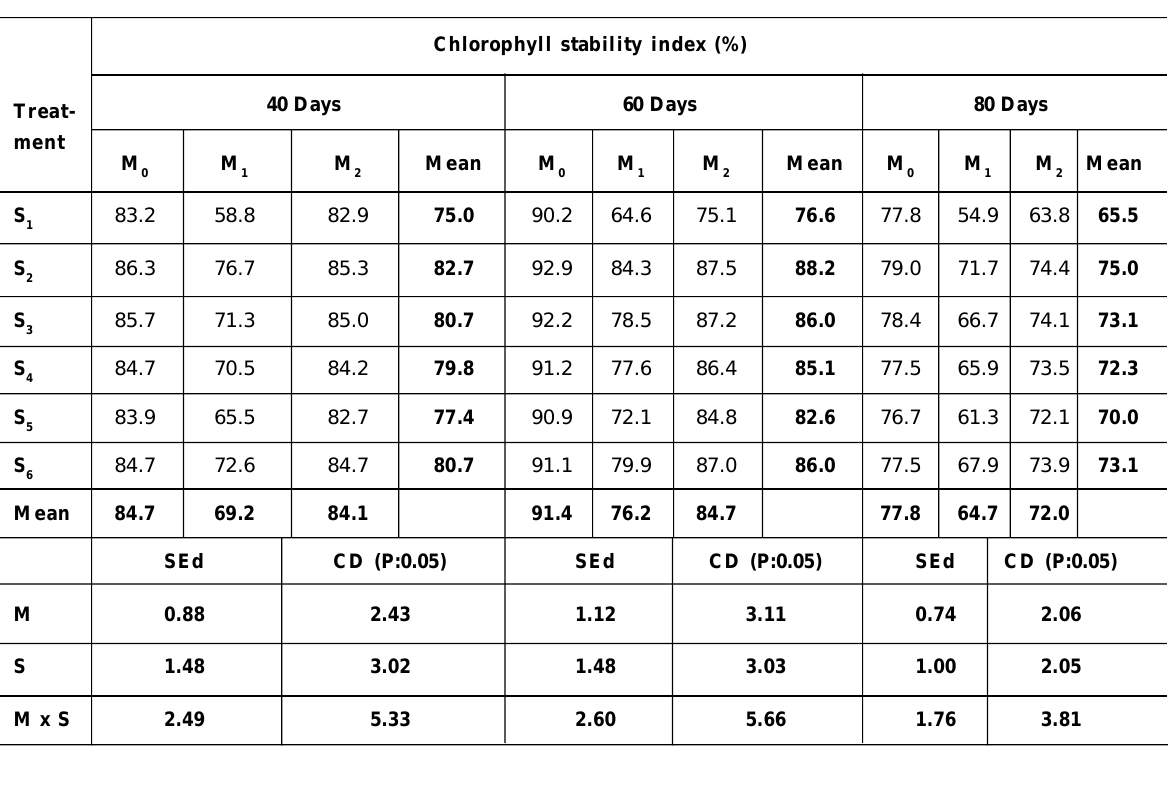
Table 3: Effect of plant growth regulating chemicals on membrane stability index (%) in bhendi hybrid CO under moisture stress conditions